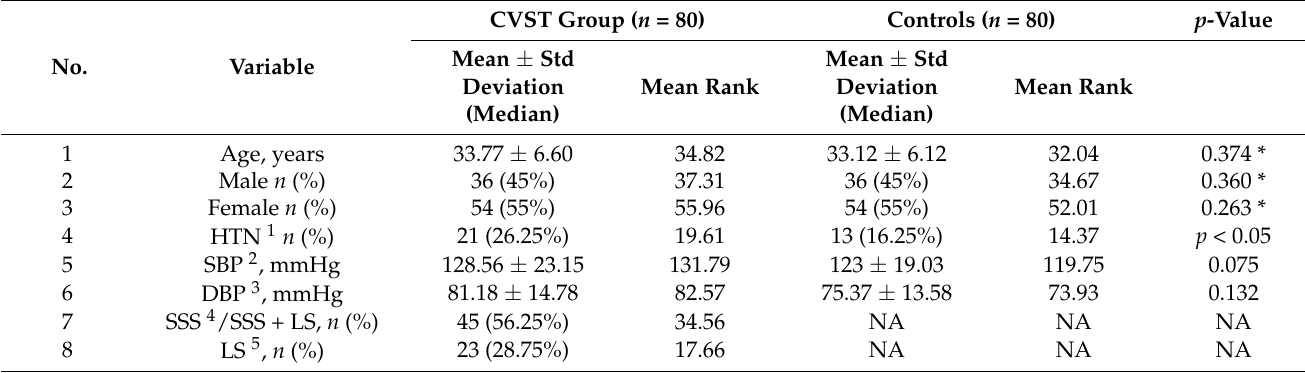
Table 1. Demographic data, clinical baseline, neuroradiological findings and biochemical characteristics of the study participants using the Mann- Whitney U Test, Chi Square Test and Fisher